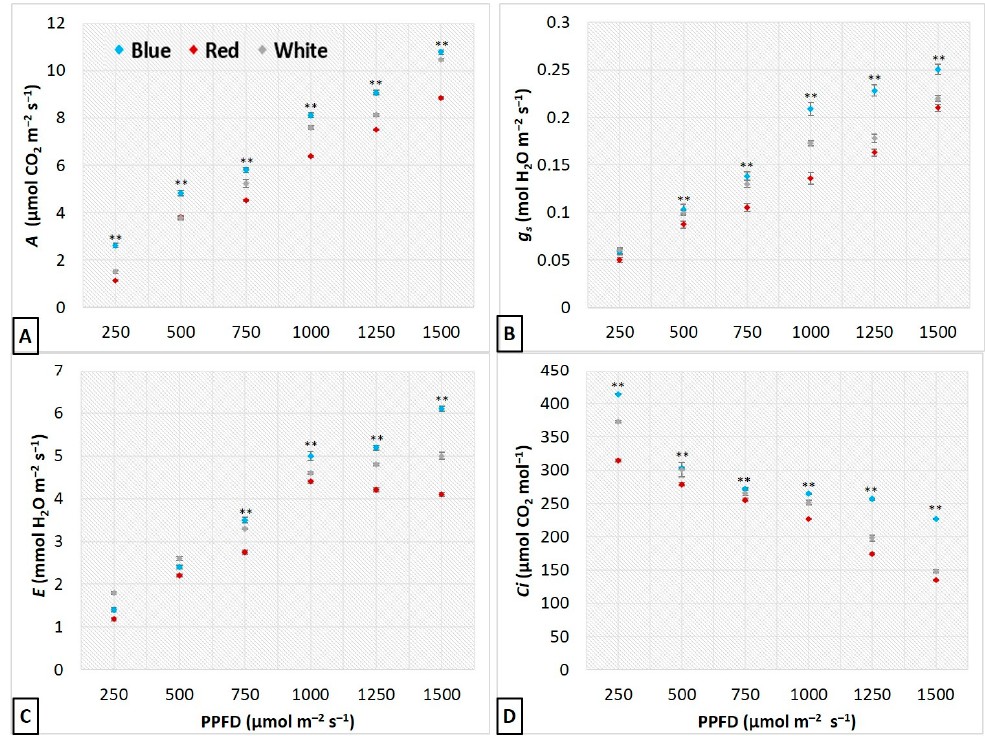
Figure 2. Effects of blue, red, and white LED light on leaf gas exchange at different photosynthetic photon flux densities (PPFD) in Eustoma leaves. ( A ), A (µmol CO 2 m − 2 s − 1 ); ( B ), g s (mol H 2 O m − 2 s − 1 ); ( C ), E (mmol H 2 O m − 2 s − 1 ), and ( D ), C i (µmol CO 2 mol − 1 ). Data represent means ± SE ( n = 10); asterisks indicate a significant difference among the LED treatments at P < 0.01 (**) by Tukey’s HSD-test. The SE bar may not be seen on data points due their small values.